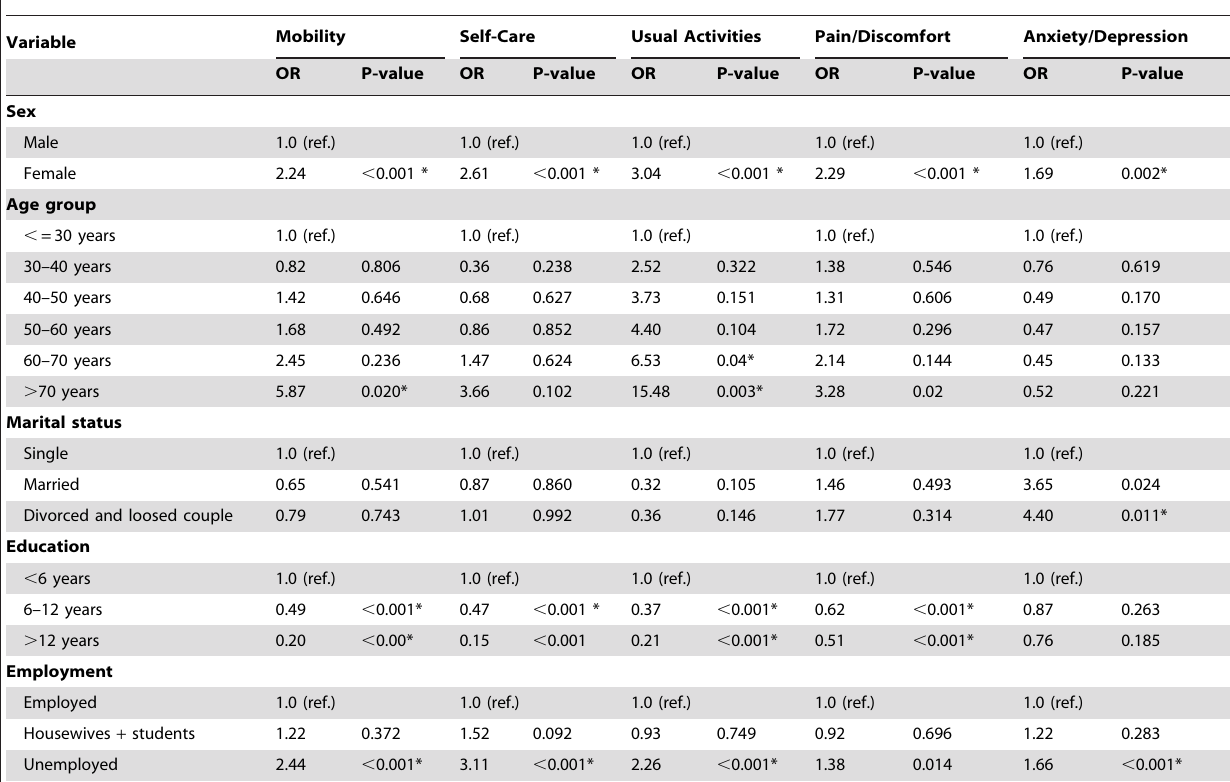
Table 4. Results of multivariate logistic regression